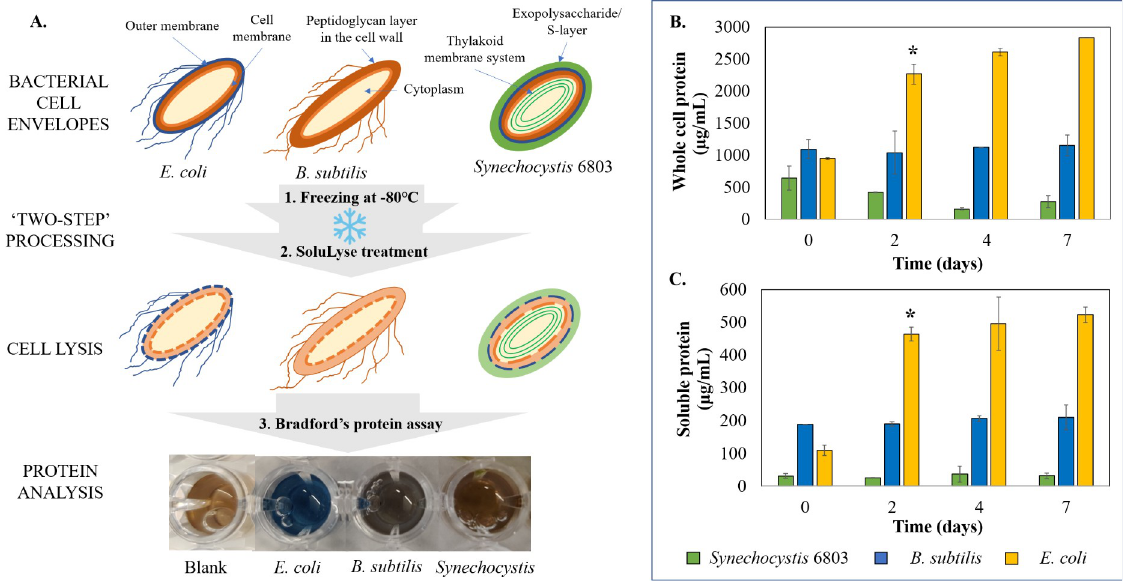
Fig 3. Impact of ULT storage on protein extraction efficiency. A) Schematic representation of bacterial cell structures used in this study and the steps followed for protein extraction and analysis. Comparative protein concentrations of whole (B) and soluble fraction of (C) cell lysates from E . coli (yellow), Synechocystis 6803 (green) and B . subtilis (blue) over 7 days of ULT-storage. E . coli significantly displayed highest protein yields. The experiments were performed in biological triplicates. Statistical significance was determined using t-test (p < 0.05). Data represented as Mean ± SD, n =